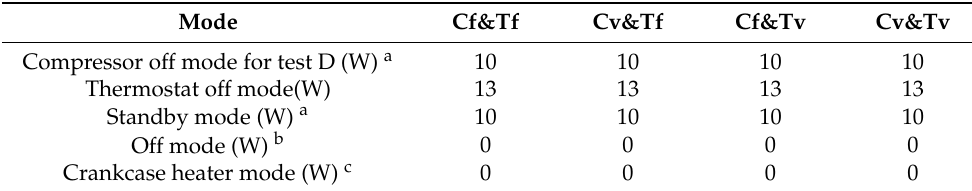
a Liquid pumps are assumed to be off during this mode of operation. b The unit is supposed to be switched off during off mode. c The heat pump does not include a crankcase heater device so the energy consumption for this mode of operation is